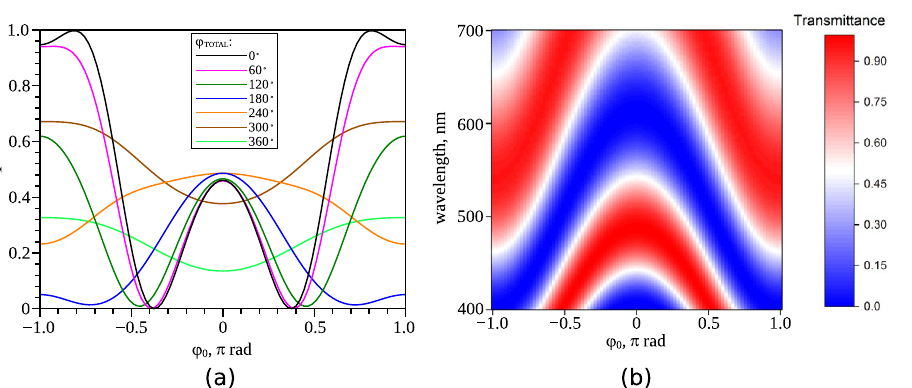
Figure 4. The dependencies of the transmittance T of light ( (cid:31) = 546 nm) passed through the LC cell in the crossed circular polarisers on the angle ϕ 0 obtained for the various twist angles of the director ϕ TOTAL ( a ). The dependencies of the transmittance T on the angle ϕ 0 and light wavelength (cid:31) obtained for ϕ TOTAL = 60 ◦ ( b ). The calculations were performed by the Berreman transfer-matrix method for the angles α = 5.33 ◦ , θ d / 2 = 40 ◦ , LC layer thickness d = 12.7 µ m, and the refractive indices of